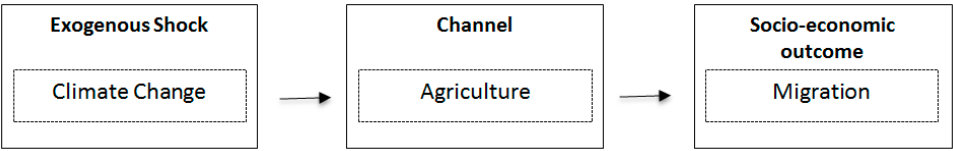
Figure 2. The effect of climate change on migration throughout the agricultural channel.